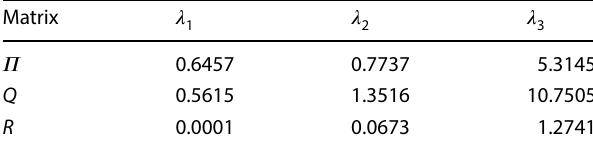
Table 4 Eigenvalues of 𝛱 , Q and R